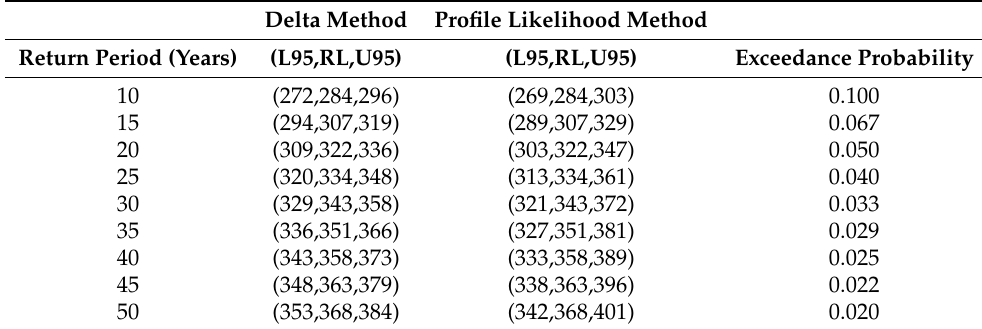
Table 6. Estimating return levels using delta and profile methods for the GEVD r = 8